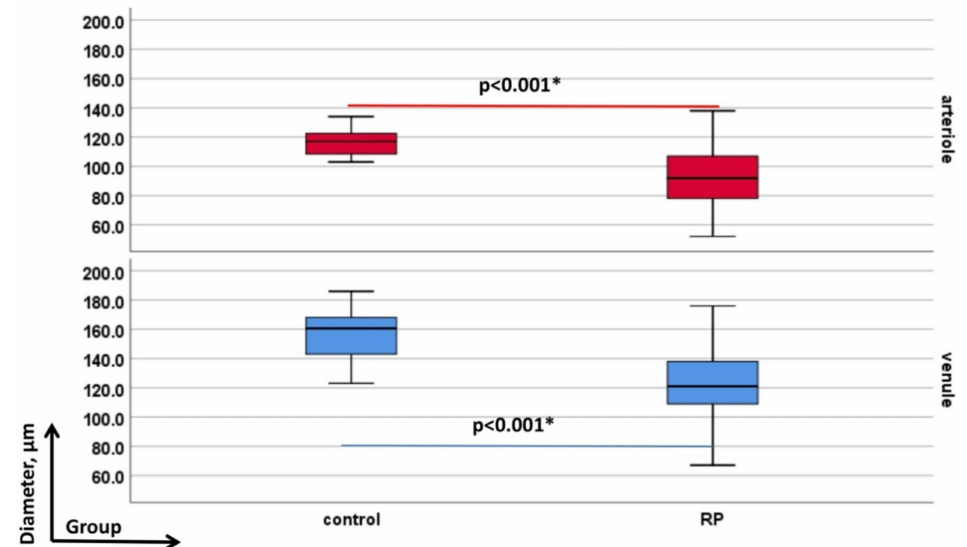
Figure 4. Depicts retinal vessel diameters’ data of arterioles (D-A, red-colored) and venules (D-V, blue-colored). In each graph the groups as labelled on the y-axis (from left to the right: controls and retinitis pigmentosa (RP)) and the evaluated diameter-parameters—on the x-axis. All significant p -values are given in bold with